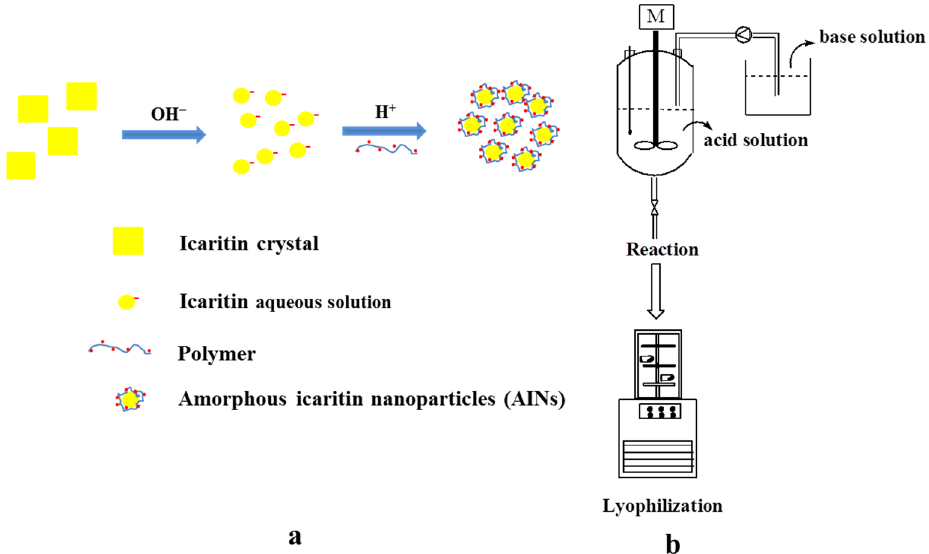
Figure 2. Schematic illustration of the construction of AINs ( a ) and a diagram of the experimental process for our RPT ( b ). AINs: amorphous icaritin nanoparticle; RPT: reactive precipitation technique.